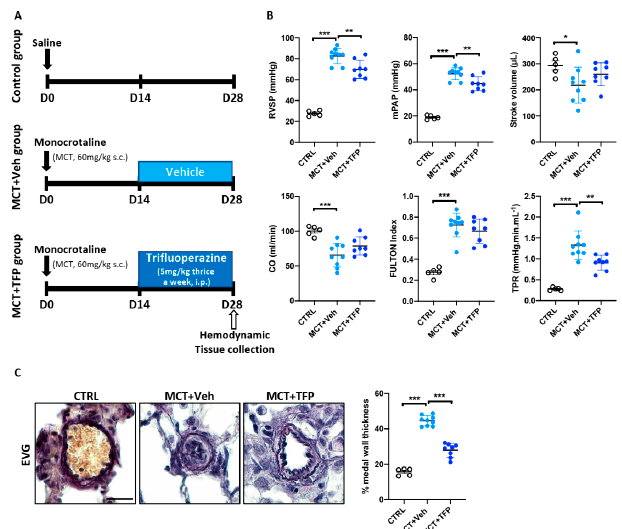
Figure 6 Figure 6. Effects of trifluoperazine (TFP) treatment on monocrotaline (MCT)-induced PAH in rats. ( A ) Schematic representa- tion of the experimental protocol for induction and therapeutic intervention in the MCT-induced PAH rat model. ( B ) Right ventricular systolic pressure (RVSP), mean pulmonary artery pressure (mPAP), stroke volume (SV), cardiac output (CO), Fulton index and total pulmonary resistance (TPR) were measured in control (CTRL), MCT + vehicle (Veh) and MCT + TFP rats; n = 5 to 9 rats/group. ( C ) Representative images of distal pulmonary arteries (PAs) stained with Elastica van Gieson (EVG). The graph on the right represents the degree of medial wall thickness. Data are presented as mean ± SEM; * p < 0.05; ** p < 0.01; *** p < 0.001. Scale bars: 20 µ